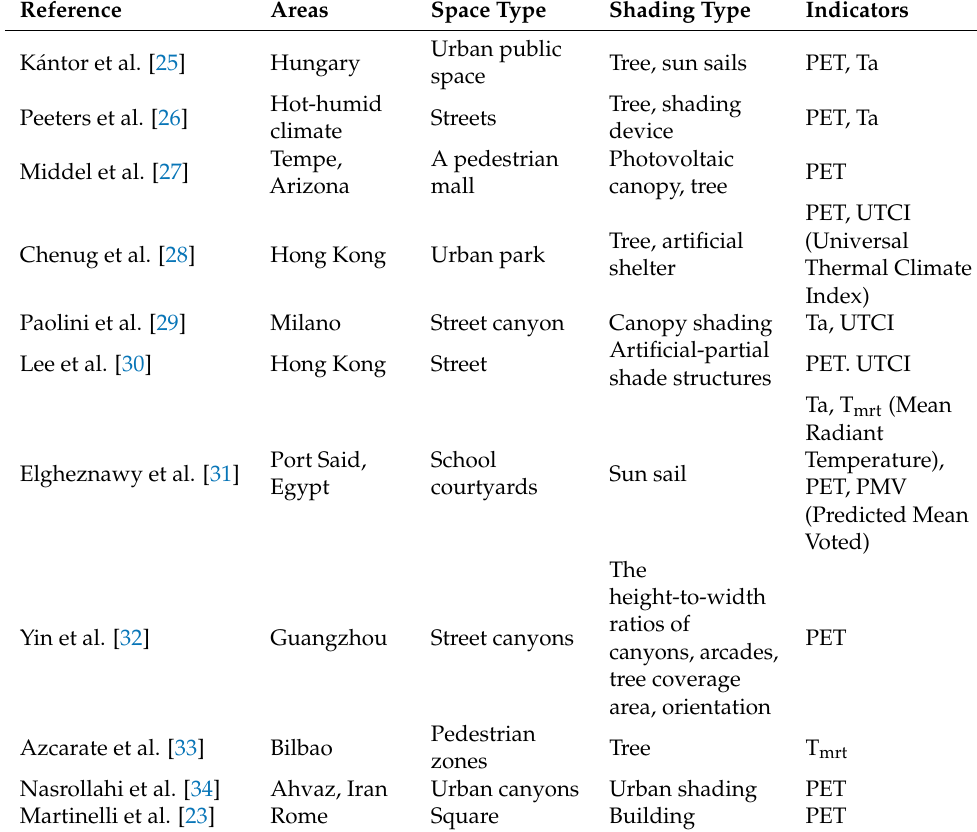
Table 1. A summary of previous research on